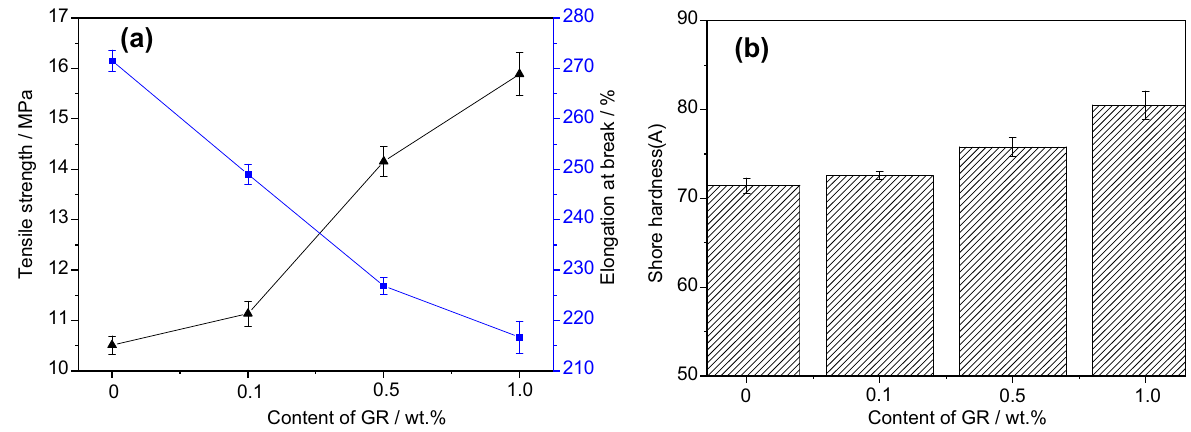
Figure 8: The e ff ect of graphene content on ( a ) tensile properties and ( b ) hardness.